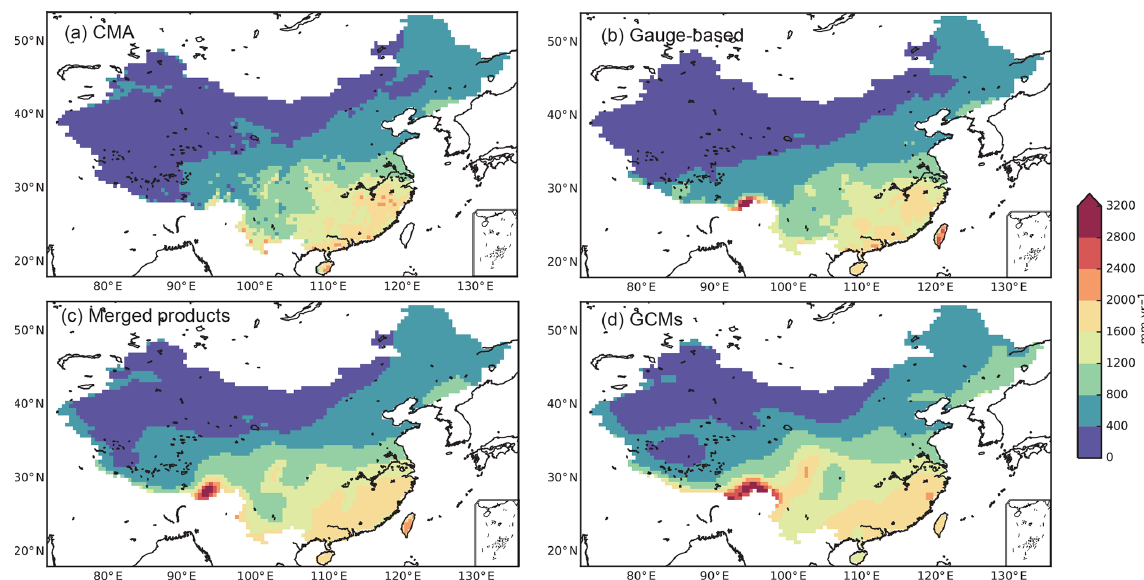
Figure 4. Annual precipitation over a long-term period (1979–2005) for each group of precipitation datasets. (a) Annual precipitation of the CMA dataset, (b) ensemble means of the annual precipitation over the precipitation products in gauge-based precipitation excluding CMA, (c) ensemble mean of the annual precipitation of all merged products, and (d) ensemble means of the annual precipitation of all GCMs. The observations in Taiwan are not released in the CMA